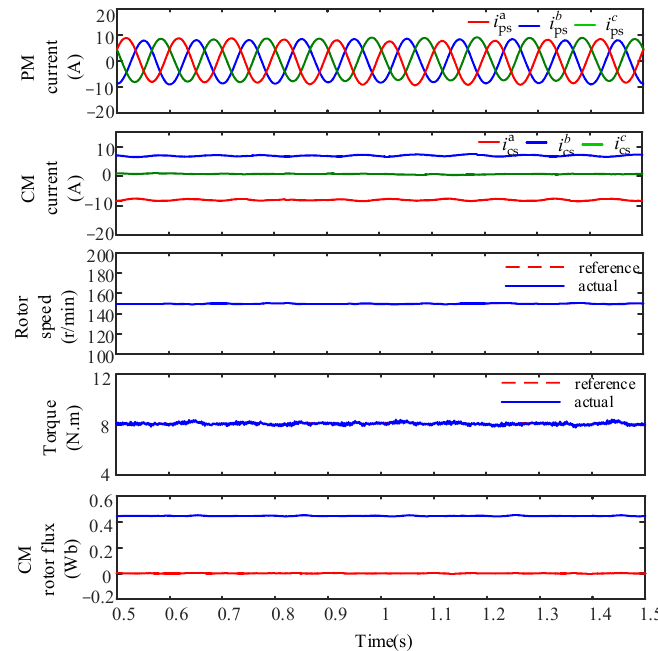
Figure 18. Experimental results at a synchronous speed of 150 r/min.